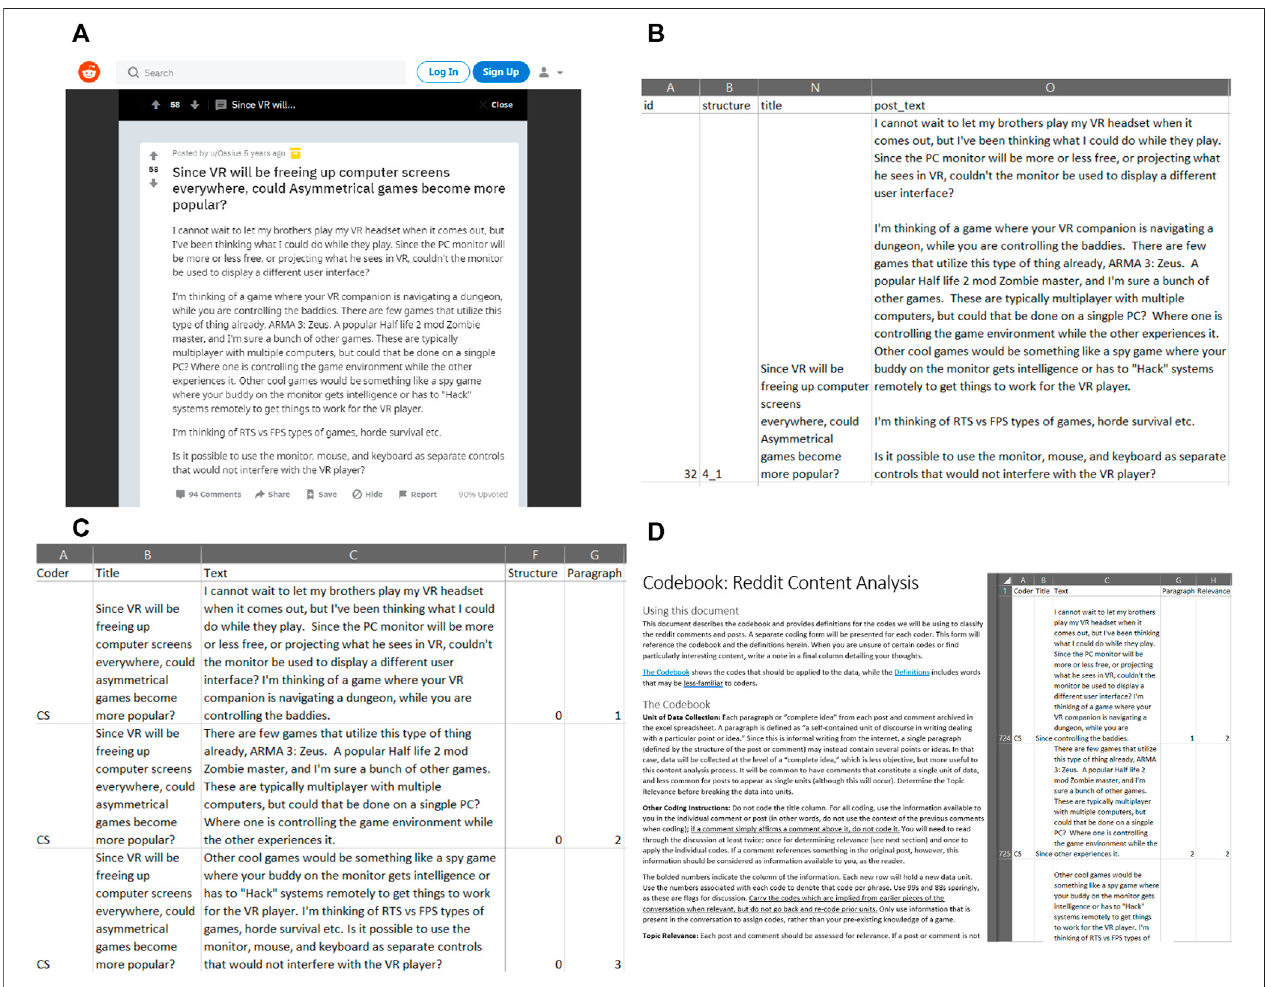
FIGURE 1 | An example of the unitization process for a single post: (A) Posts matching speci fi c keywords and phrases, such as this one, were scraped using RedditExtractoR; (B) Thescraped Redditpostsandassociateddatawerecompiledintoasinglespreadsheet; (C) Thecorpuswasrestructured soastosupport human coding, and the data were unitized into paragraphs with one per row; (D) Manual coding was performed by trained researchers, who fi rst identi fi ed the relevance of the entry. The full text of these images is available as part of the appendices and Supplementary Materials .